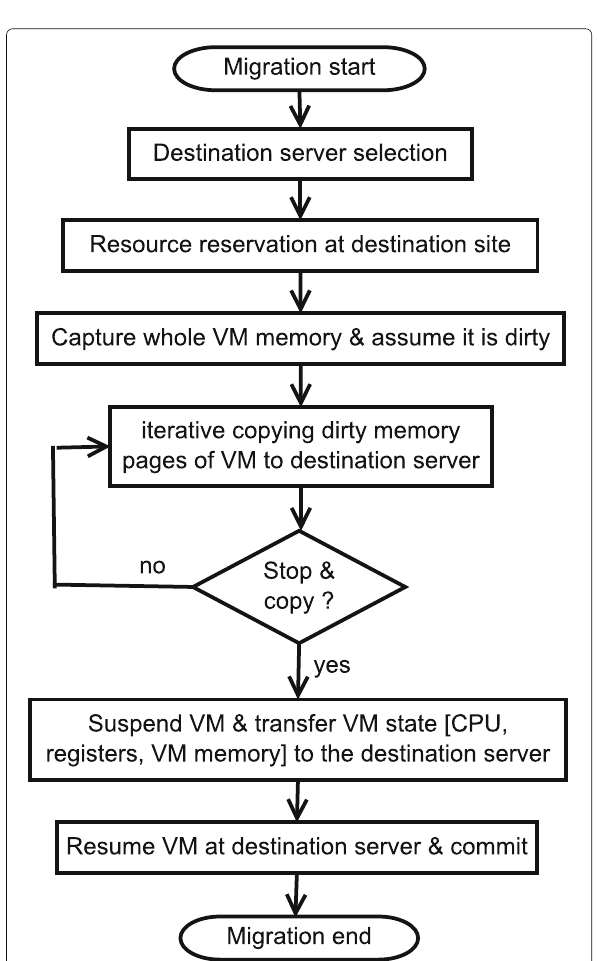
Fig. 2 Basic steps of VM migration follow in pre-copy